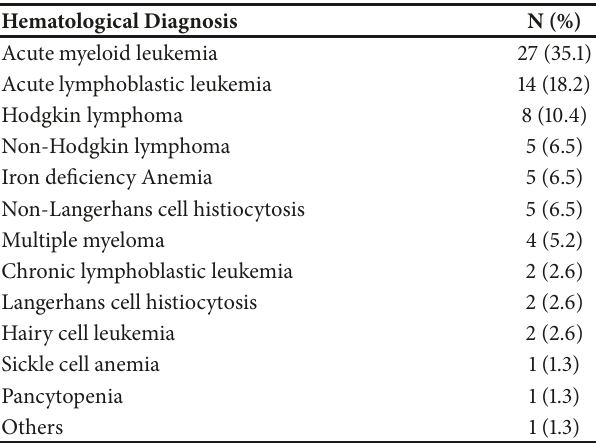
Table 1: Underlying hematological